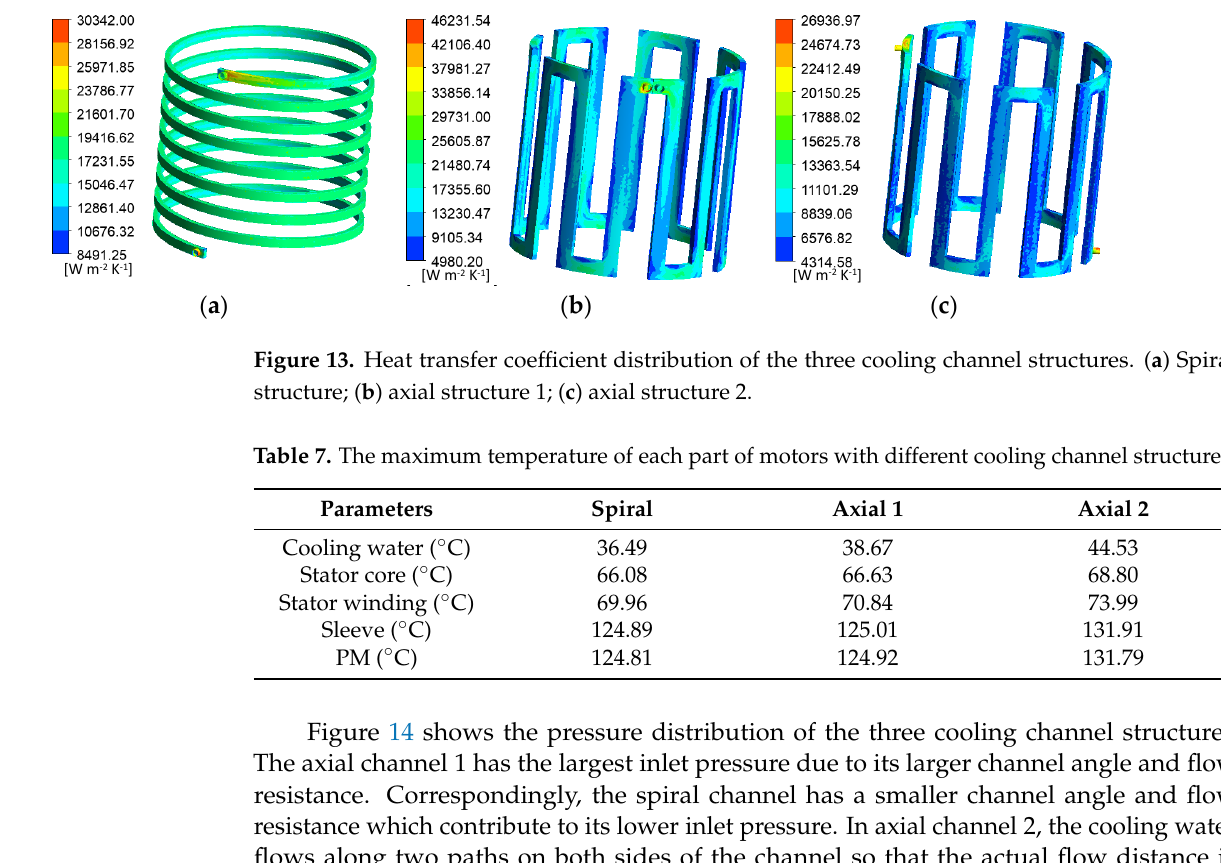
Figure 14. Pressure distribution of the three cooling channel structures. ( a ) Spiral structure; ( b ) axial structure 1; ( c ) axial structure 2.